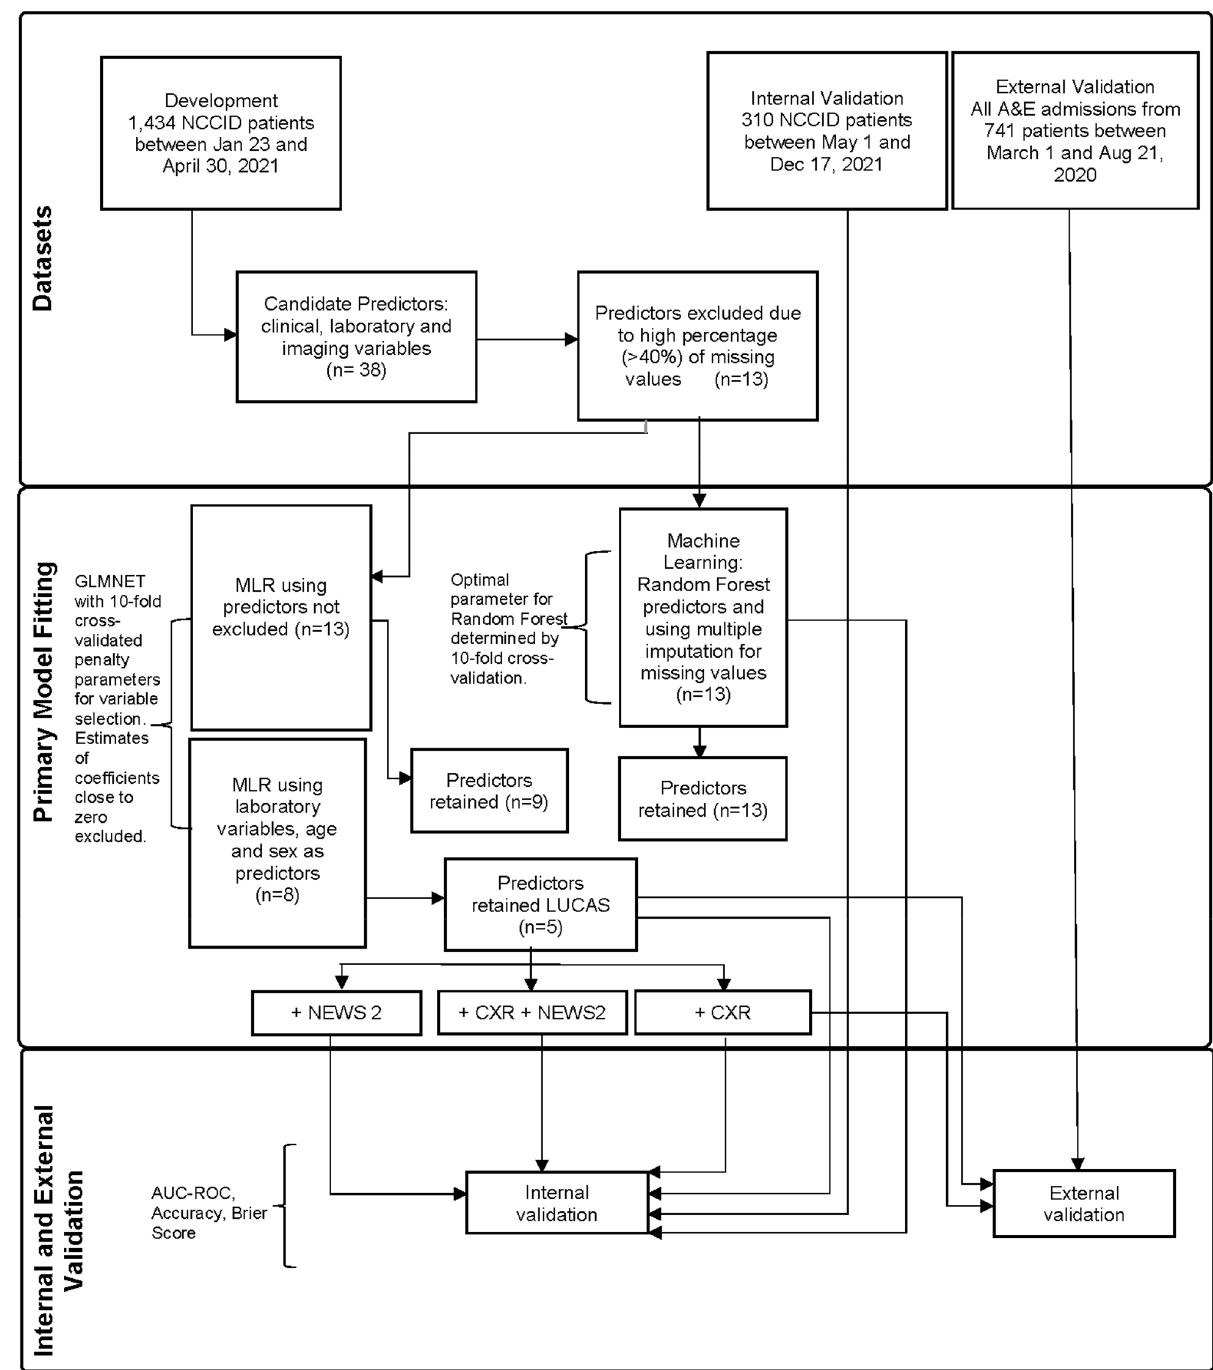
Figure 2. Model development, internal and external validation workflow. AUC-ROC, area under the receiver operating characteristic curve; GLMNET, Lasso and Elastic-Net Regularised Generalised Linear Models; MLR, multivariable logistic regression; LUCAS, model using Lymphocyte, Urea, CRP, Age, Sex; CXR, Chest X-ray; NEWS2, National Early Warning Score; n , the number of